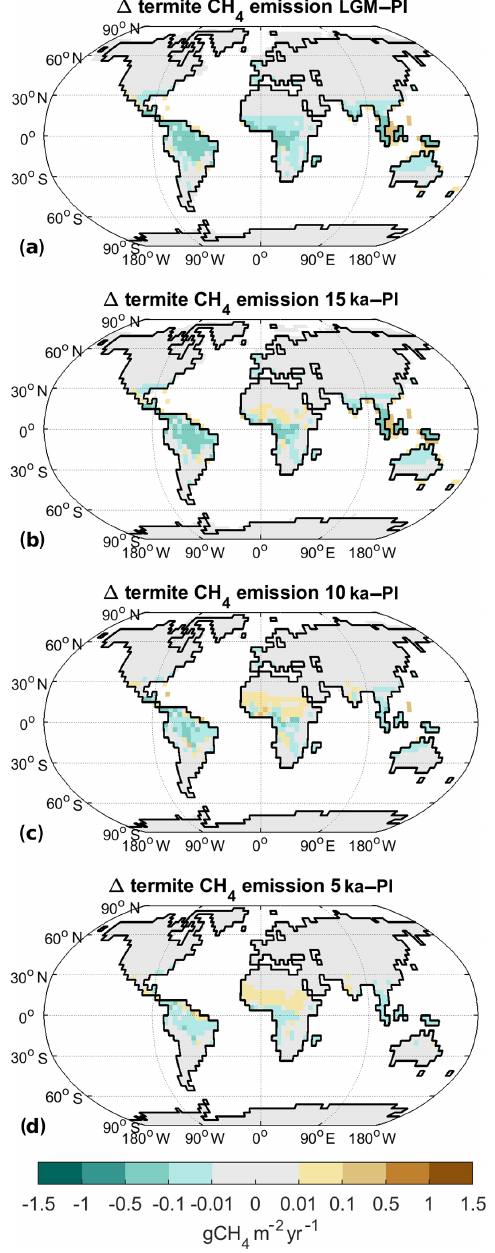
Figure 9. Difference in methane soil uptake to preindustrial for (a) LGM, (b) 15ka, (c) 10ka, and (d) 5ka.